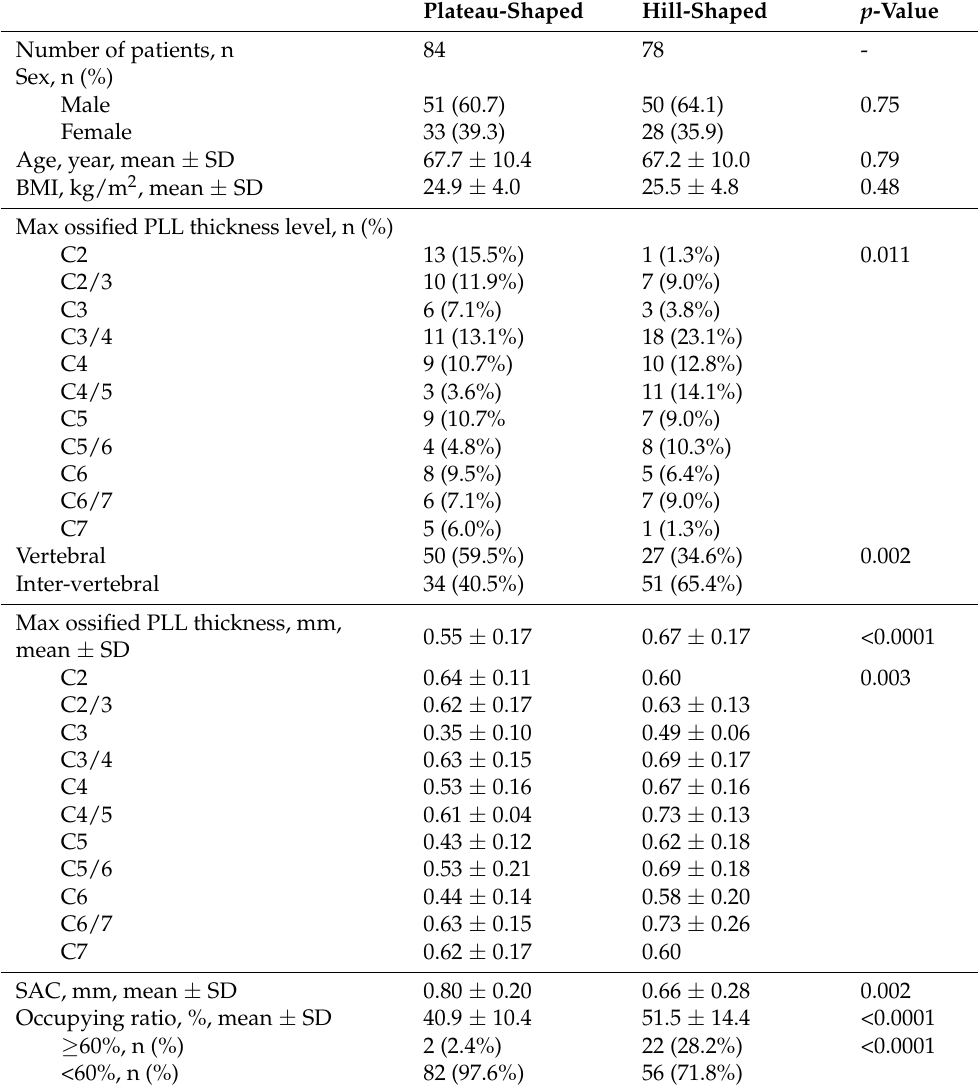
Table 1. Demographic data and ossified lesion characteristics of patients with OPLL. Plateau-Shaped Hill-Shaped p